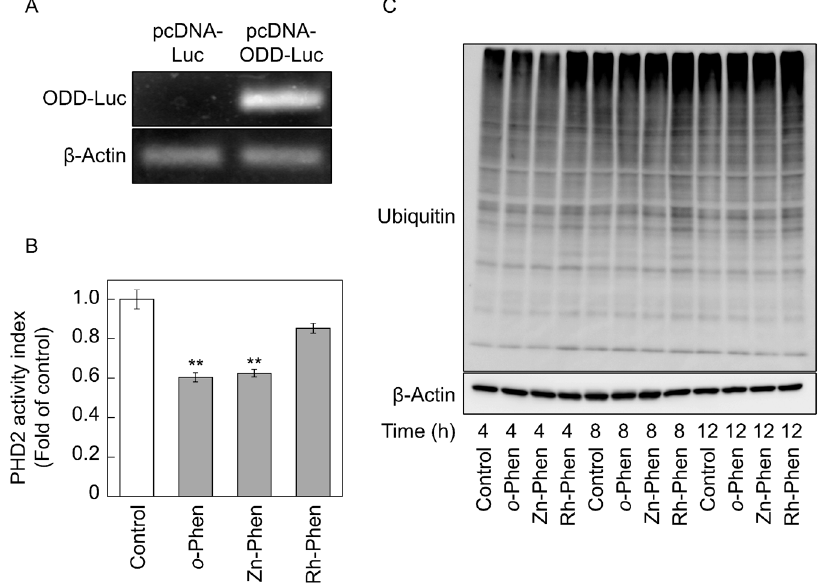
Figure 4. Effects of o -Phen, Zn-Phen, and Rh-Phen on prolyl hydroxylase domain-containing protein 2 (PHD2) activity in vascular endothelial cells. ( A ) Bovine aortic endothelial cells were transfected with pcDNA-Luc or pcDNA-ODD-Luc at 37 °C for 24 h. Amplified DNA products were separated by agarose gel electrophoresis and stained using ethidium bromide; ( B ) Bovine aortic endothelial cells were transfected with pcDNA-ODD-Luc at 37 °C for 12 h, treated with o -Phen, Zn-Phen, or Rh-Phen at 5 µM each at 37 °C for 24 h, and PHD2 activity was subsequently analyzed by luciferase assay. Values are means ± S.E.M. of five samples. ** p < 0.01 vs. control; ( C ) Bovine aortic endothelial cells were treated with o -Phen, Zn-Phen, or Rh-Phen at 5 µM each at 37 °C for 4, 8, and 12 h, and levels of ubiquitinated proteins were detected by Western blot analysis.